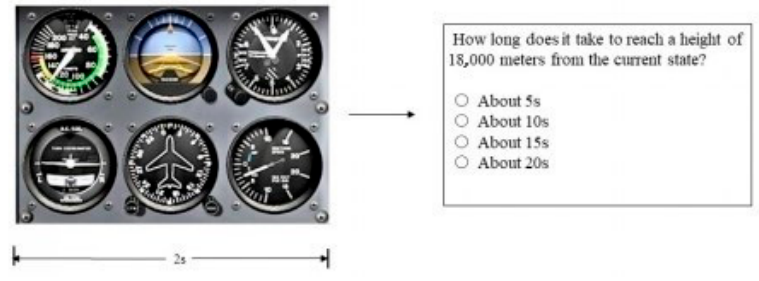
Figure 3. SA task example.